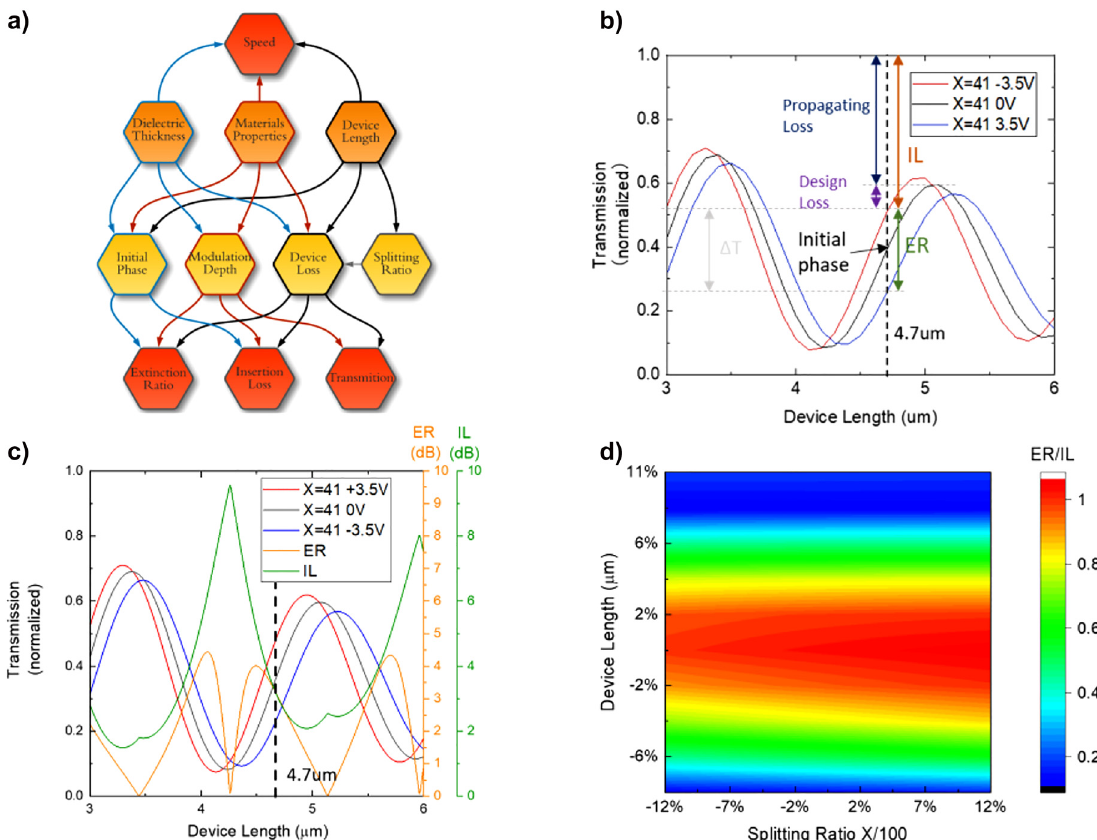
Figure 3: Relations between variables and performances. (a) Flow chart of Mach – Zehnder modulator analysis. Variables are dielectric thickness (gating oxide thickness), material properties, device length, and splitting ratio. The performances are ER, IL, transmission, and speed.(b)TransmissionofONstate,0biasstate,andOFFstateoscillatewithinthedevicewithadielectricthicknessof15nmundervoltageof + 3.5 V, 0 V, and − 3.5 V when splitting ratio is 41:59. Propagating loss is caused by absorption, while the design loss is caused by insuf fi cient phase shift. (c) Transmission, corresponding ER, and IL varies with device length. ER = 3 dB and IL = 2.9 dB when device length is 4.7 μ m (d) Fabrication tolerance of device length and splitting ratio for the proposed